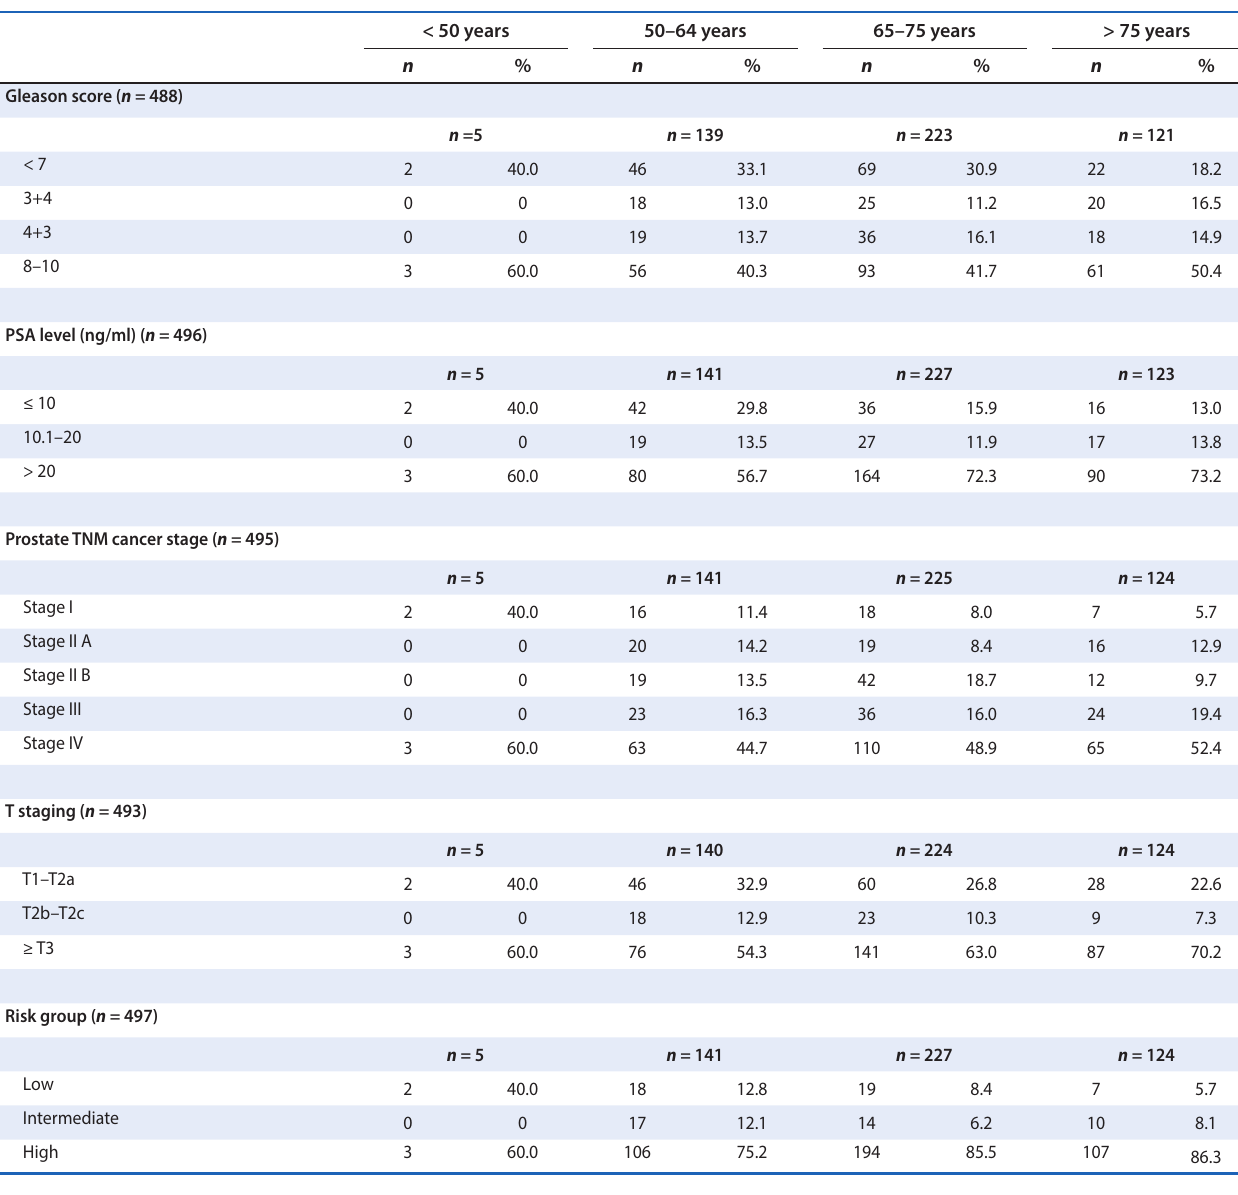
Table 4: Distribution of the Gleason score, PSA level, TNM stage, T staging, and risk group stratification according to age groups